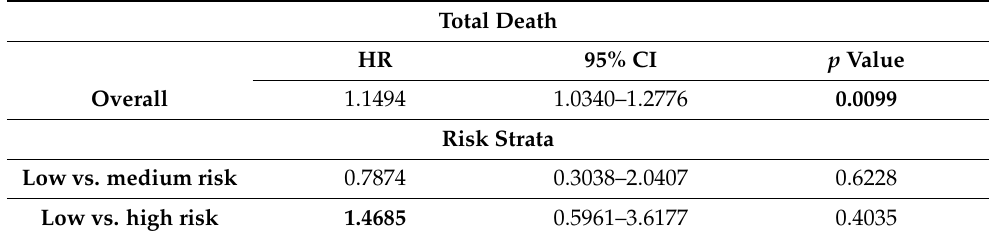
Table 8. Total all-cause-death hazard ratios for C 2 HEST risk stratification in CAD cohort.